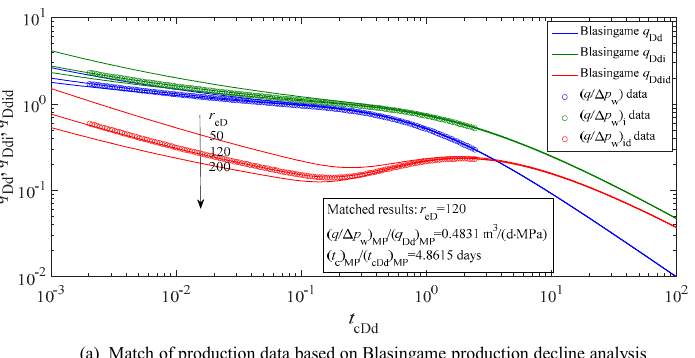
Figure 14. Normalized rate functions and modified normalized rate functions for CRP case of 3 30m d q = .